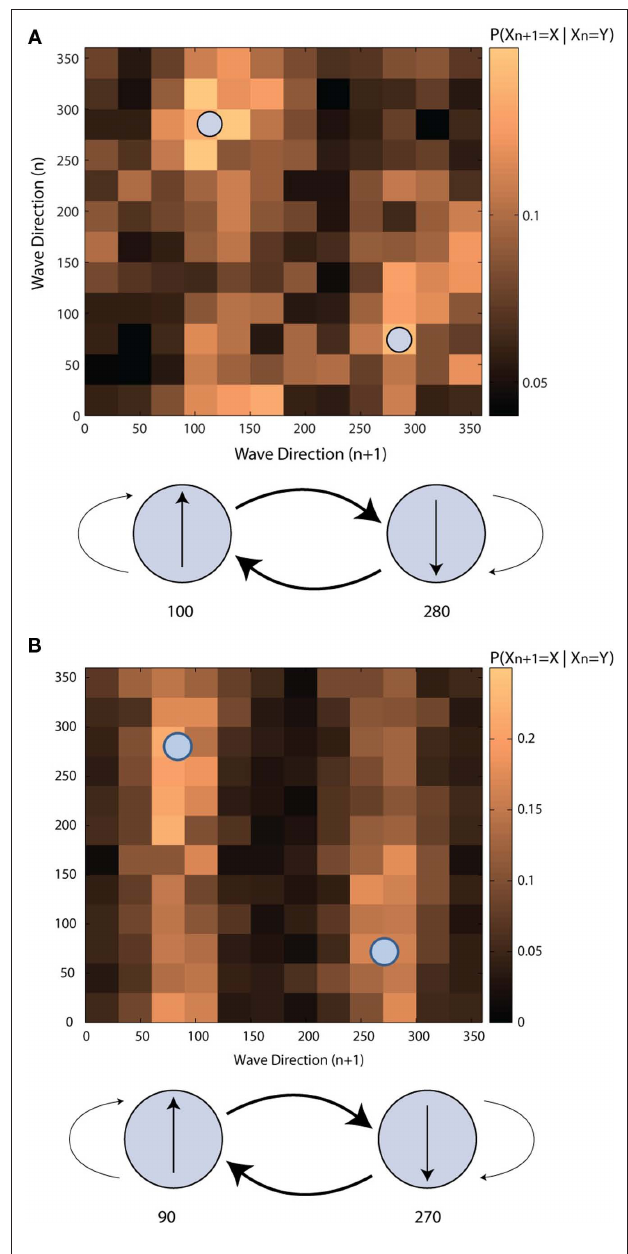
Figure 5 | Transition probability matrices of directions of sustained beta waves. (A) The human subject (B) the NHP subject. Each small square in the upper figures corresponds to a conditional probability of the direction of an n + 1 th sustained wave is at a certain angle given the direction of an n -th sustained wave. The lower figure shows interactions between two dominant sustained